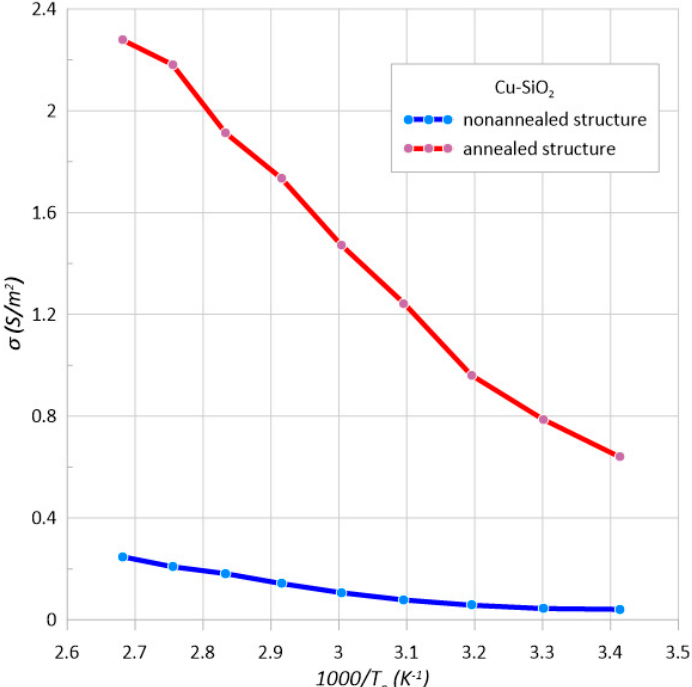
Figure 4. Arrhenius plot of conductivity at the frequency f = 100 Hz of the Cu–SiO 2 nanocomposite before and after annealing at T a = 473 K.